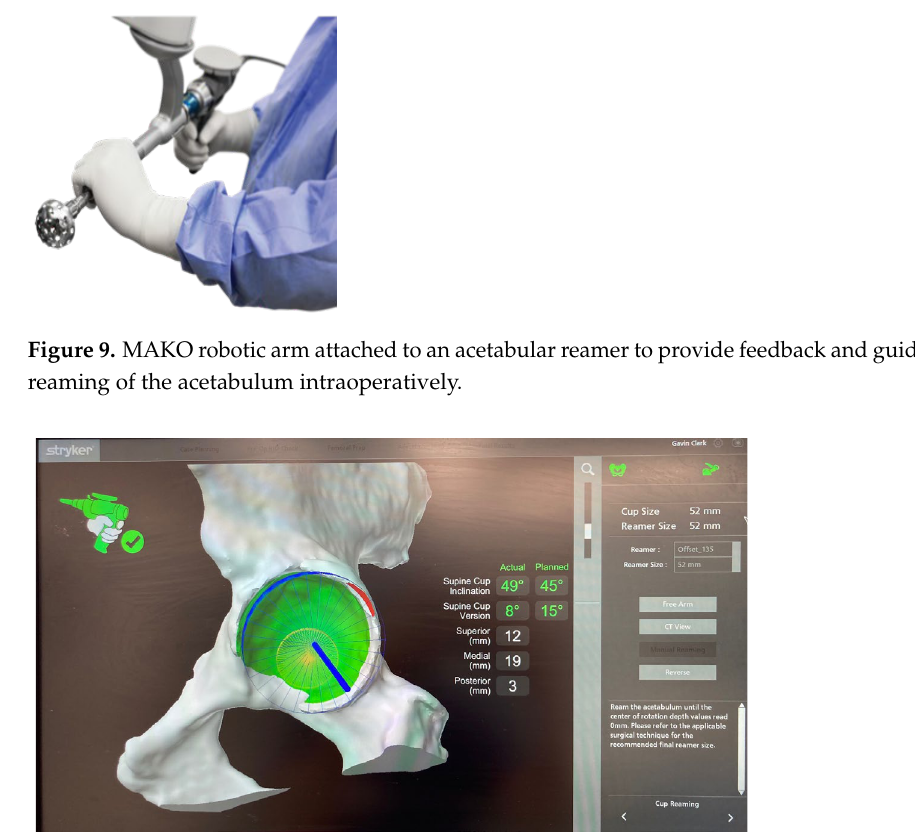
Figure 10. Intra-operative images detailing acetabular reaming relative to pre-operative plan. The blue areas indicate the reamer position. The green area is the area to be reamed, and the red area denotes minimal deviation from pre-operative plan (any further and the system would shut off), and the numbers in white indicate real-time distance from pre-operative plan as the operator reams.